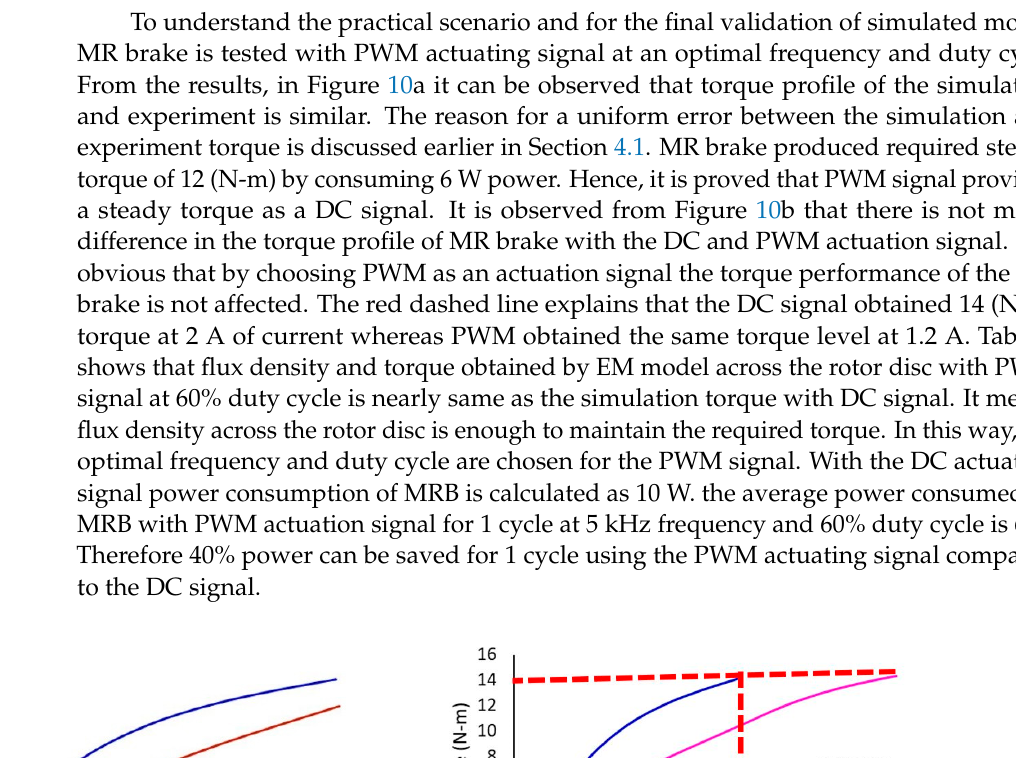
Table 2. Results of PWM actuation signal.